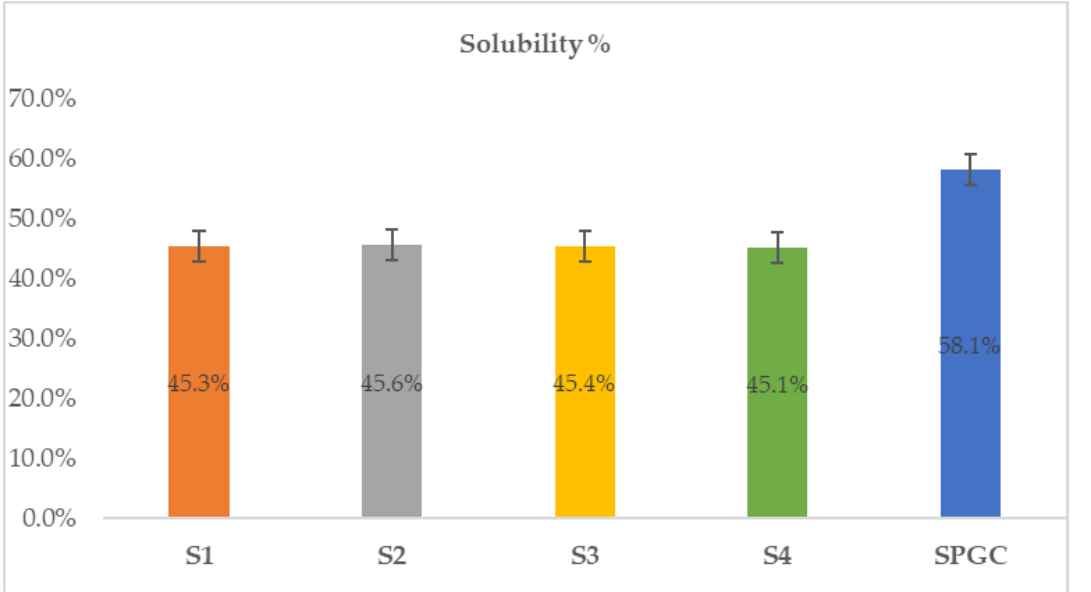
Figure 6. The solubility percentage of the starch-based films (S1–S4) was affected by adding the nZnO particles.